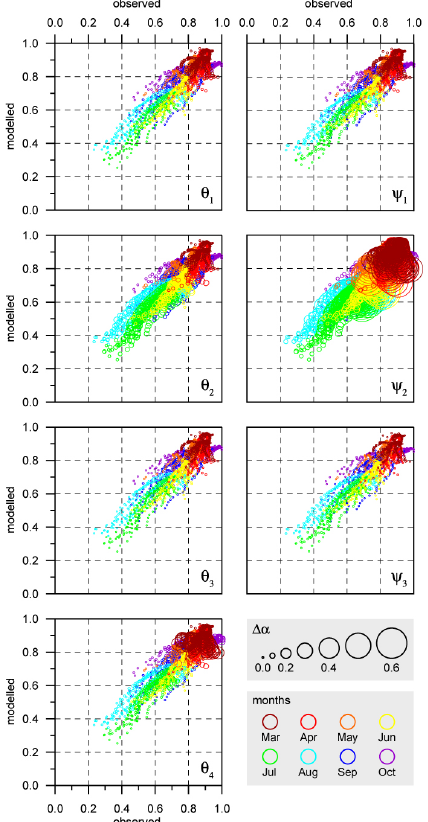
Fig. 6. Parameters of the parameter functions θ 1 − 4 (z) and ψ 1 − 3 (z) of the albedo model as resulting from the cross-validation (lower graph). Box plots are created on the basis of the 8 individual model calibrations and are designed as in Fig. 4. For better comparabil- ity, all parameters are displayed in the same order of magnitude. The conversion factors to the original values are shown in the upper graph.